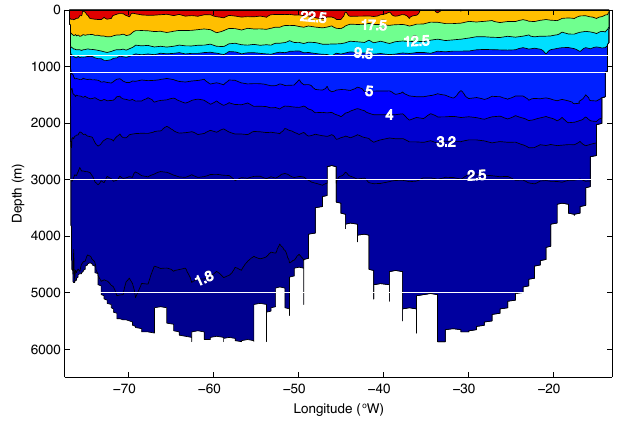
Fig. 4. Potential temperature at 25 ◦ N for the 2004 hydrographic section; contours correspond to the class partitions given in Ta- ble 3 (note that the 17.5 ◦ C isotherm is also plotted). Depth levels of 800m, 1100m, 3000m and 5000m are